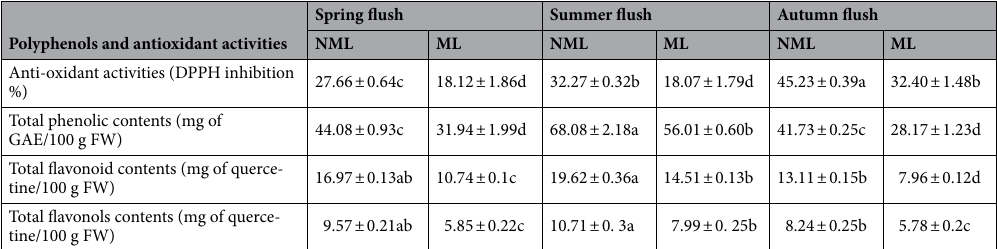
Polyphenols and antioxidant